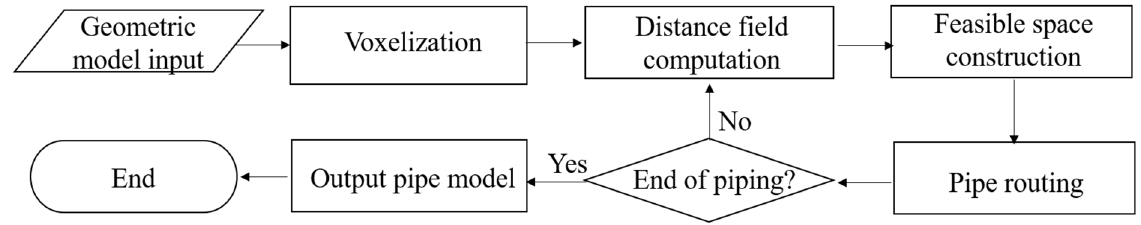
Figure 1. Flowchart of the proposed piping